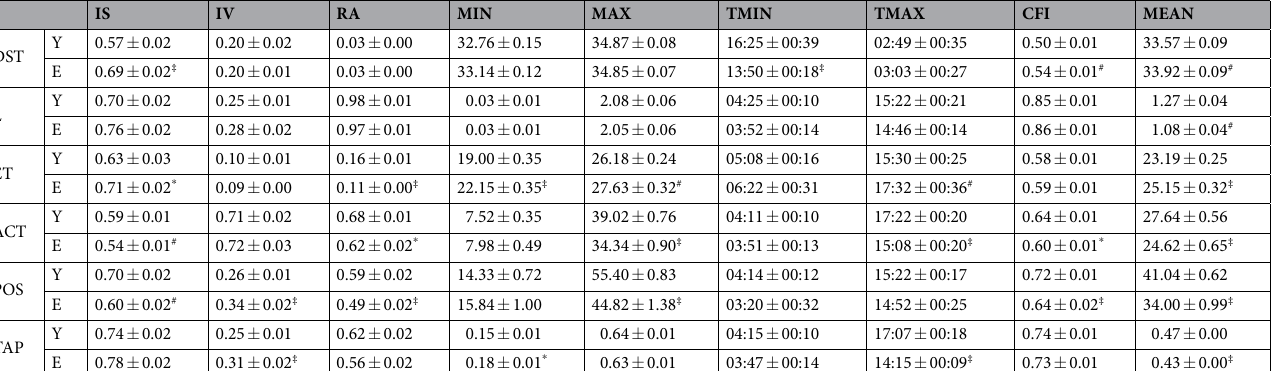
Table 1. Non-parametrical indexes of circadian rhythms according to age group (elderly participants, n = 44; young participants, n = 44). Main characteristics of the circadian rhythms and environmental preferences studied (distal skin temperature, DST; light exposure, L; environmental temperature, ET; activity, ACT, body position, POS and integrated variable TAP, TAP) for young and elderly participants (Y and E, respectively). Interdaily stability (IS), intradaily variability (IV), relative amplitude (RA), mean of the 10 consecutive hours with the lowest values (MIN), and the 5 consecutive hours with the highest values (MAX) for distal skin temperature and their respective timing (TMIN and TMAX), 5 consecutive hours with the lowest values (MIN), and the 10 consecutive hours with the highest values (MAX) for light exposure, environmental temperature, activity, body position and the integrated variable TAP and their respective timing (TMIN and TMAX), circadian function index (CFI) and mean value (MEAN). IS, IV, RA and CFI have no units, MIN, MAX and MEAN are expressed in the units of their respective variable (DST in °C, L in log 10 lux, ET in °C, ACT in °/min, POS in degrees and TAP in arbitrary units) while TMIN and TMAX are expressed in hours (hh:mm). Values are expressed as the mean ± SEM. ‡ p < 0.001, # p < 0.01 and * p < 0.05, according to General Linear Model controlling for gender with post-hoc Benjamini-Hochberg procedure for multiple